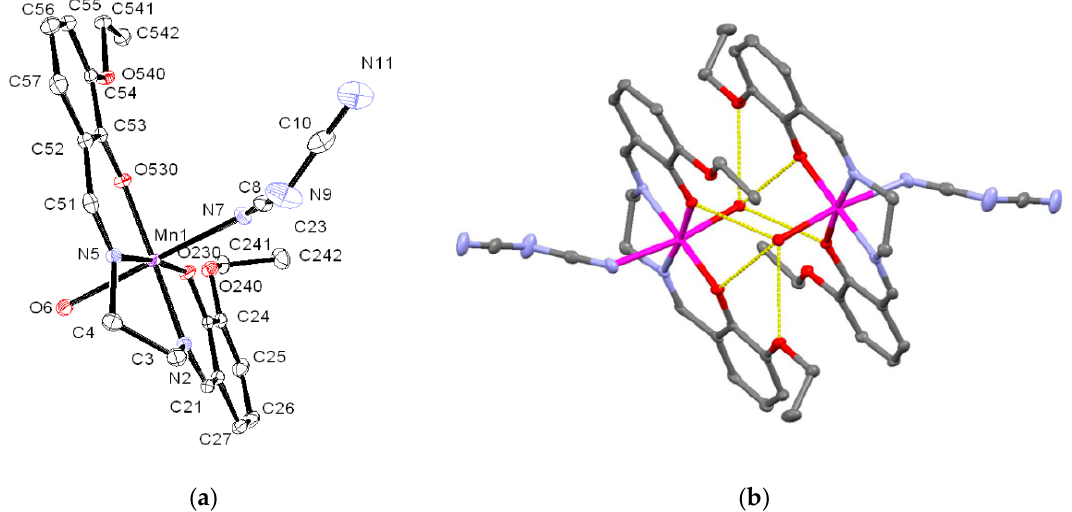
Figure 4. ( a ) ORTEP view of the monomeric unit for 1 with numbering scheme; ( b ) crystal structure of the dimeric entity for 1 (manganese ion in magenta, nitrogen in blue, oxygen in red and carbon in grey). Table 4. Selected bond lengths (Å) and angles (°) for 1.